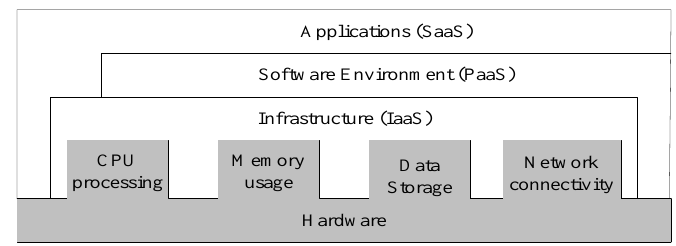
Figure 1. The basic cloud computing